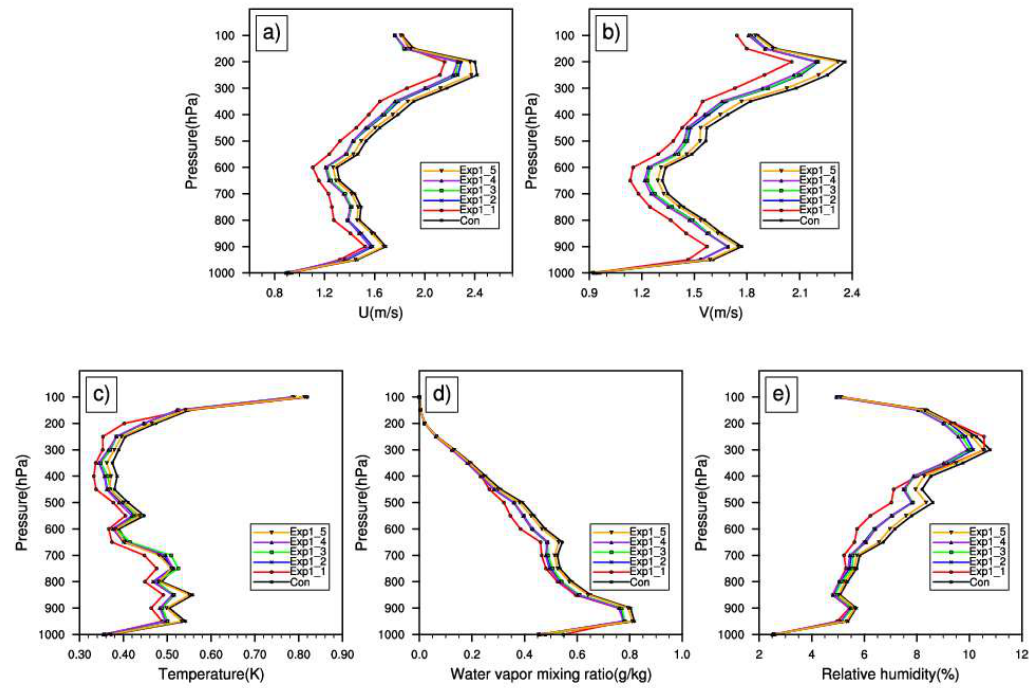
Figure 9. Vertical profiles of RMSEs in ( a ) u winds (unit: m s − 1 ) ( b ) v winds (unit: m s − 1 ) ( c ) temperature (unit: K) ( d ) water vapor mixing ratio (unit: g/kg) ( e ) relative humidity (unit: %) from the Con, Exp1_1, Exp1_2, Exp1_3, Exp1_4, and Exp1_5. Results are valid at 00:00 UTC on 29 June 2009 and are calculated for the whole horizontal